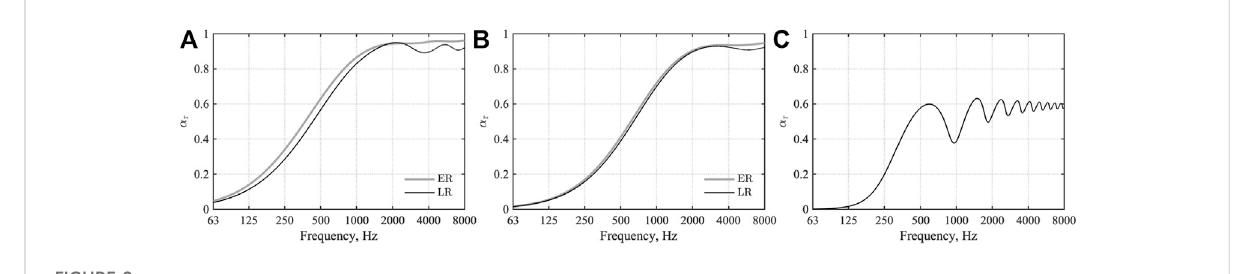
FIGURE 8 Random incidence sound absorption coef fi cient: (A) GW32K, (B) GW96K, (C) AF. ER and LR respectively denote the extended reaction model and local reaction model.